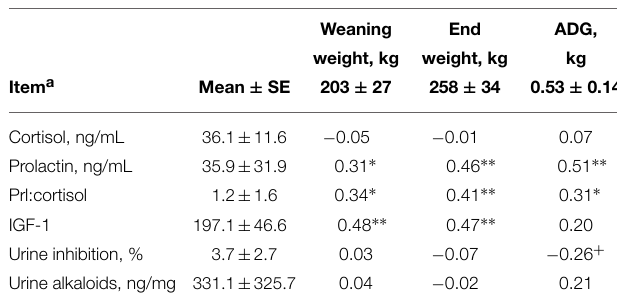
TABLE 1 | Correlations of steer weight and gain with serum hormones and urine alkaloids.